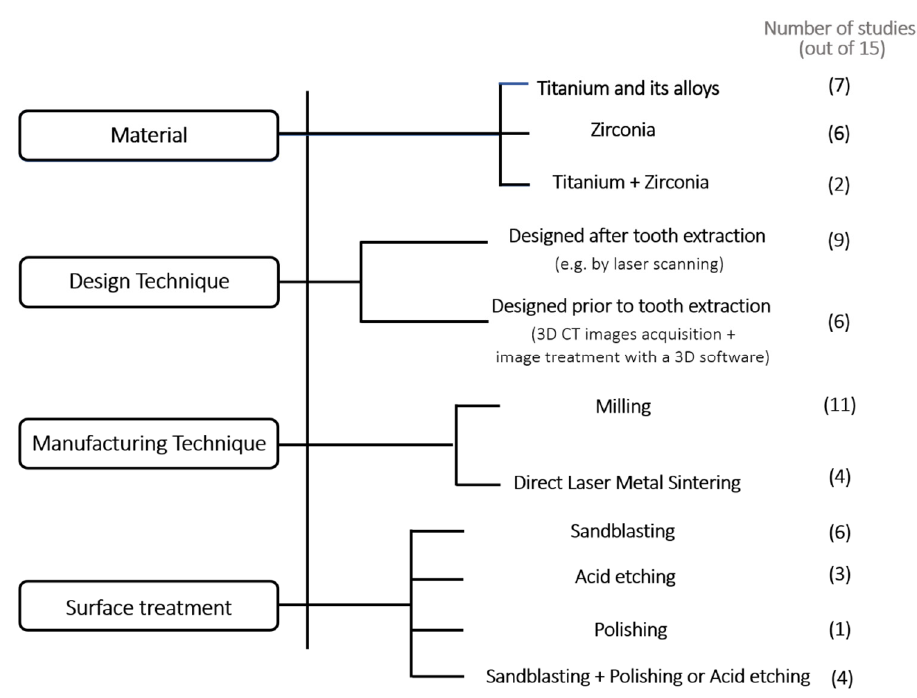
Figure 2. Schematic representation of the materials, design and manufacturing techniques, and surface treatments of the selected and analysed studies.